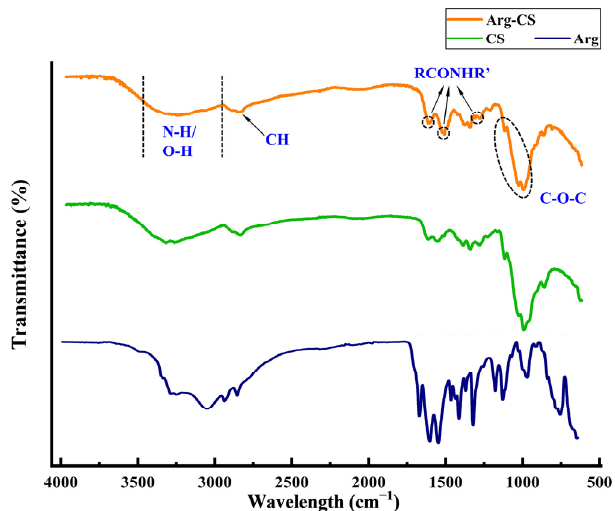
Figure 1. Amide group was formed between Arg and CS in the prepared Arg-CS. The FT-IR spectra of Arg-CS (red line), Arg (blue line), and CS (green line). CS, or prepared Arg-CS, was detected by a Thermo Scientific Nicolet iS50 FT-IR spectrometer; the characteristic peaks were assigned arrows.